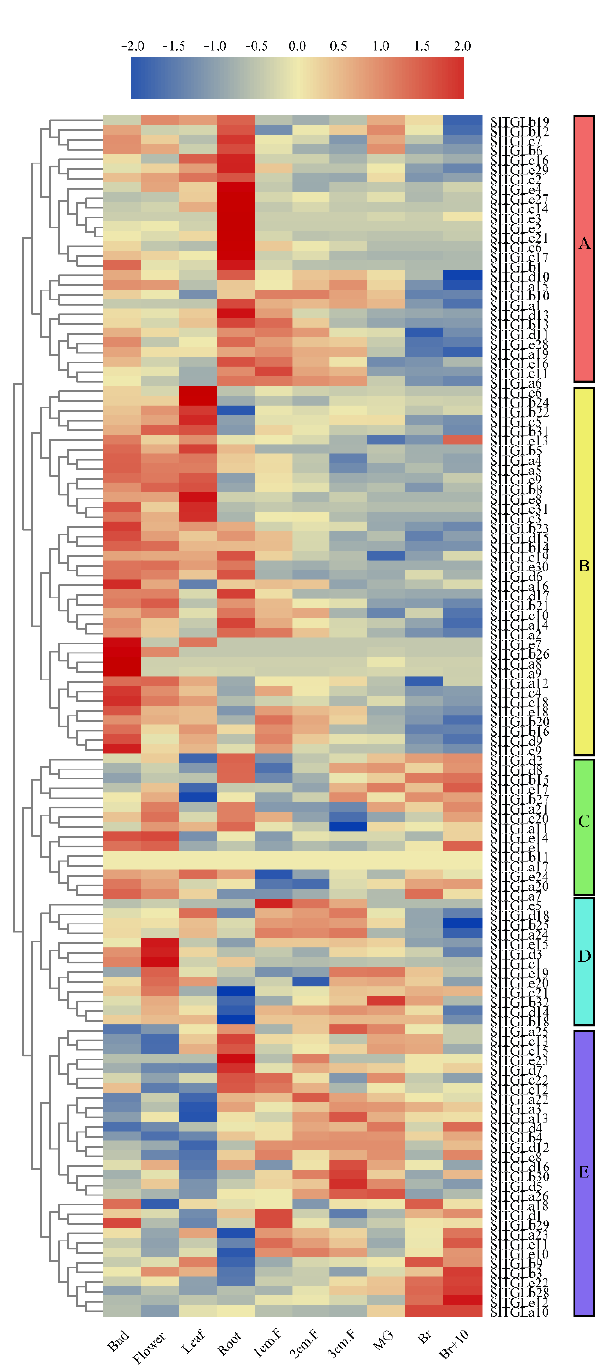
Figure 5. The expression profiles of SlTGL genes in cultivated tomato cultivar Heniz 1706 from TFGD. Heatmap of RNA-seq data of Heniz. Fully opened flowers (Flower), Bud, 1-cm fruits (1 cm. F), 2-cm fruits (2 cm. F), 3-cm fruits (3 cm. F), mature green fruits (MG), breaker fruits (Br), fruits at 10 days after breaker stage (Br+10), roots (Root), leaves (Leaf) in the middle. Heatmaps of gene expression profiles were generated using TBtools [45].